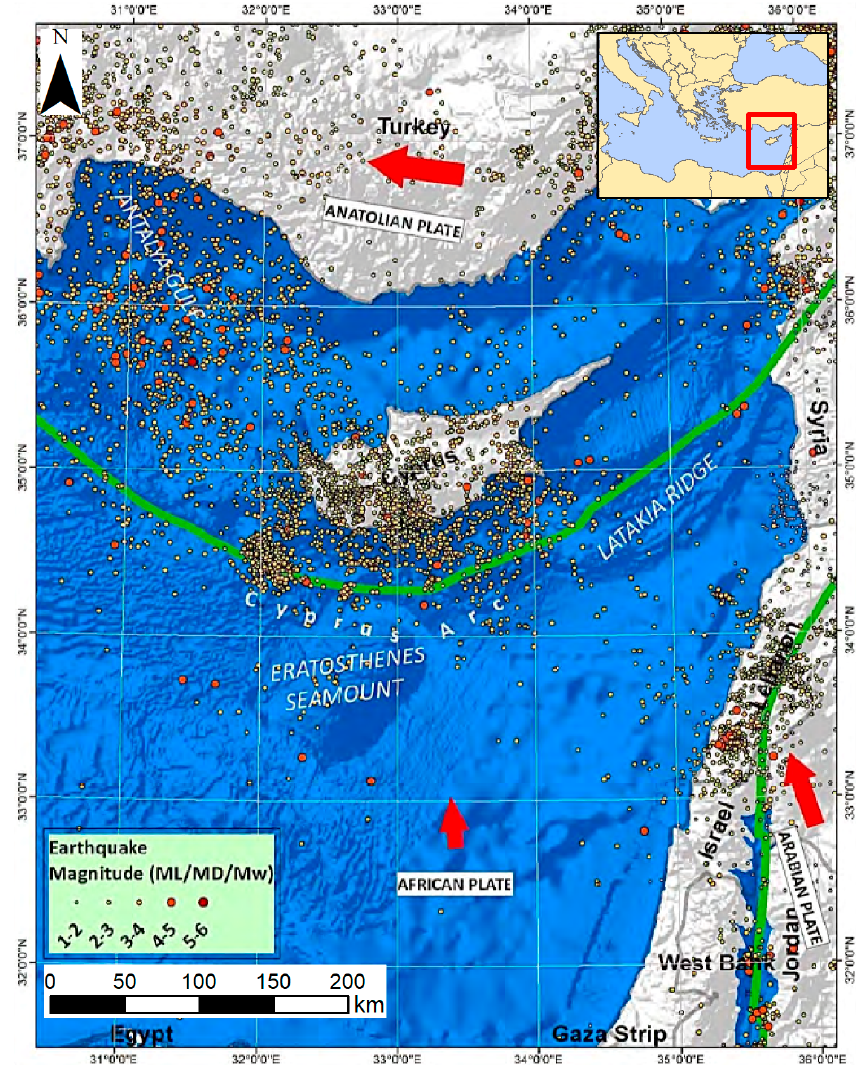
Figure 1. The Cyprus Arc and the adjacent tectonic plates [4].